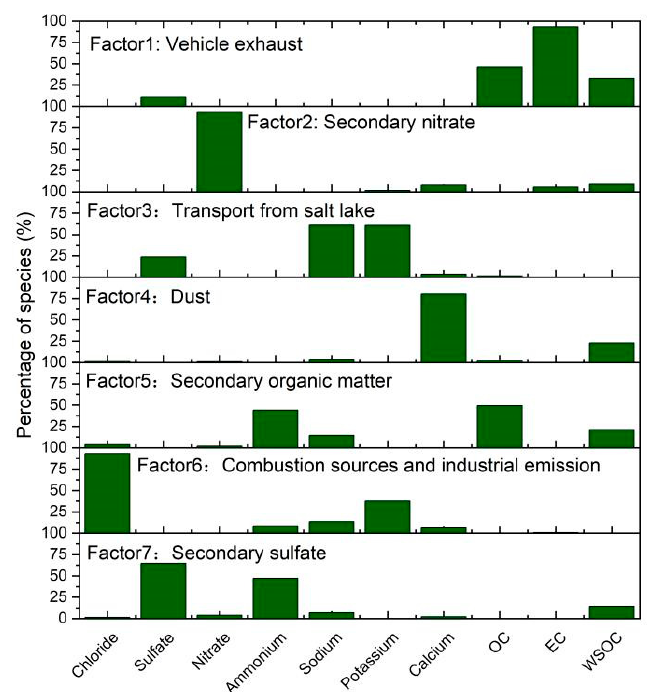
Figure 7. Source apportionment of PM 2.5 by positive matrix factorization (PMF).